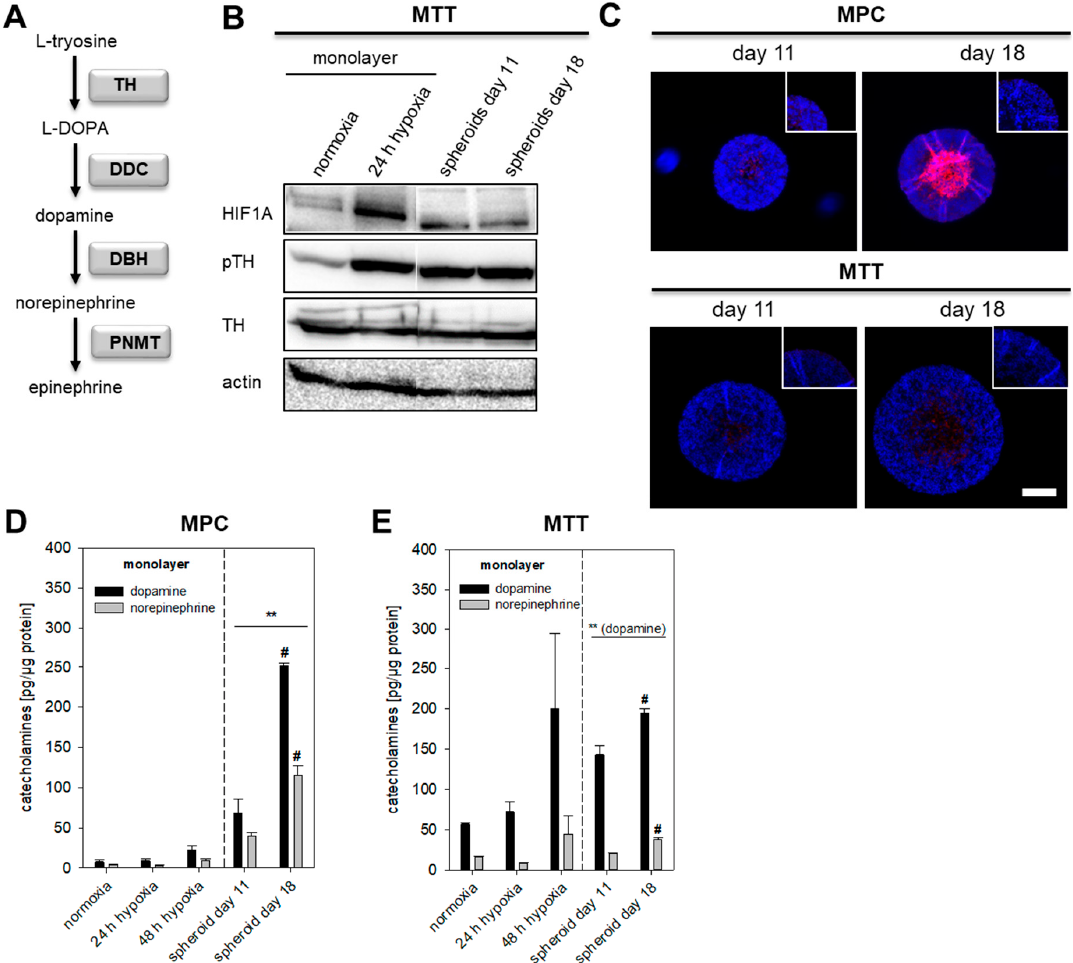
Figure 2. Impact of extrinsic and intrinsic hypoxia on catecholamine biosynthesis. ( A ) Section of biosynthetic pathways of catecholamines. Squares highlighted the underlying enzymes (TH: tyrosine hydroxylase; DDC: DOPA decarboxylase; DBH: dopamine β -hydroxylase; PNMT: phenylethanolamine N -methyltransferase). ( B ) Effect of extrinsic and intrinsic hypoxia on the protein expression and phosphorylation of TH at Ser40 in MTT cells. ( C ) Immunohistochemical staining showed an increased expression of TH (red) in the necrotic and hypoxic core of the spheroid (DAPI, blue). Scale bar: 200 µ m. Catecholamine content of ( D ) MPC and ( E ) MTT cell spheroids in comparison to monolayer